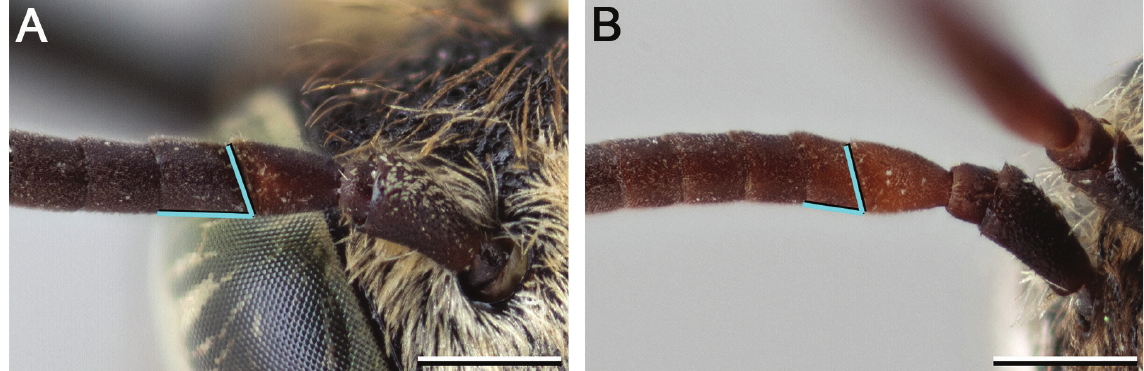
Fig. 29. Antenna (basal portion) of female. A . E. minimus (Robertson, 1902), in which F2 is noticeably longer than wide. B . E. asperatus Cockerell, 1910, in which F2 is not noticeably longer than wide. Scale bars = 0.5